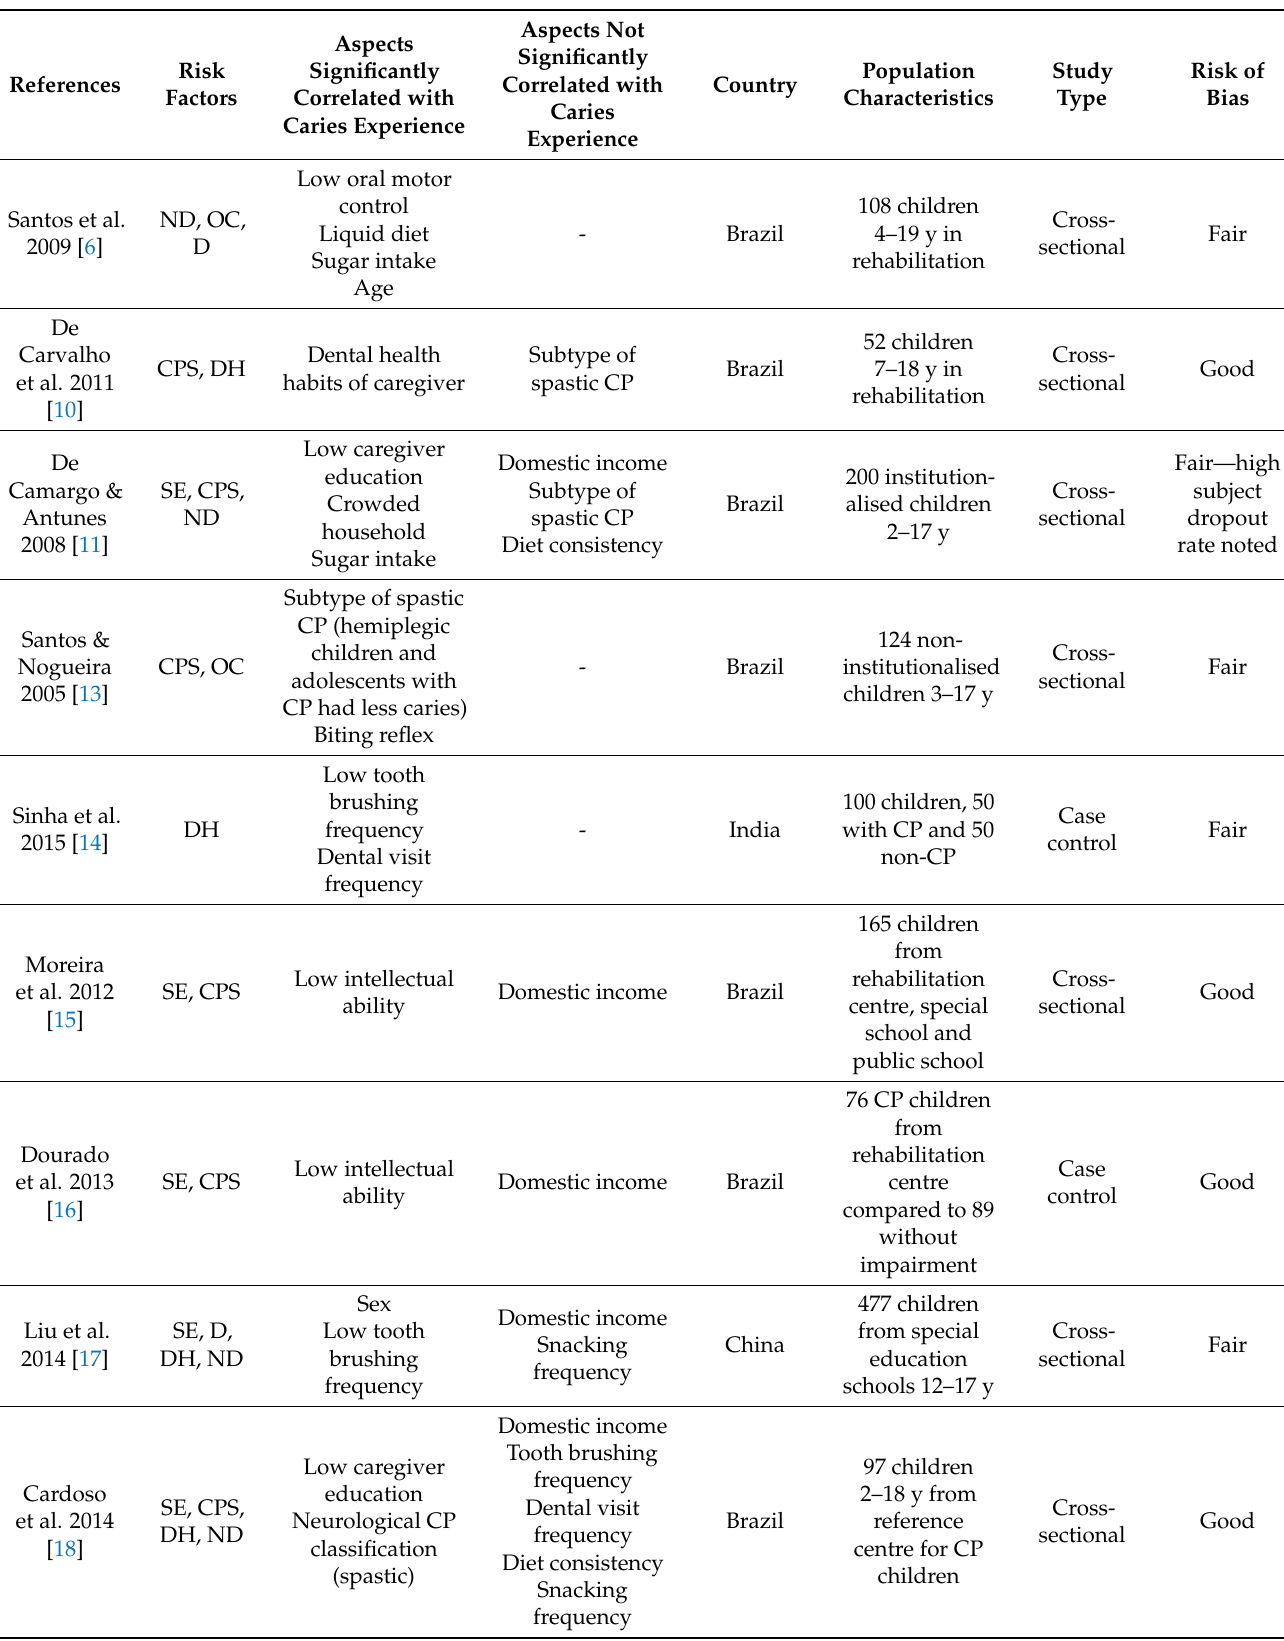
Table 1. Relationship between risk factors and aspects correlated with caries experience (N = 30): Socioeconomic factors (SE), Cerebral Palsy Subtype (CPS), Demographics (D), Condition of Oral Cavity (OC), Dental Habits (DH) and Nutrition and Diet